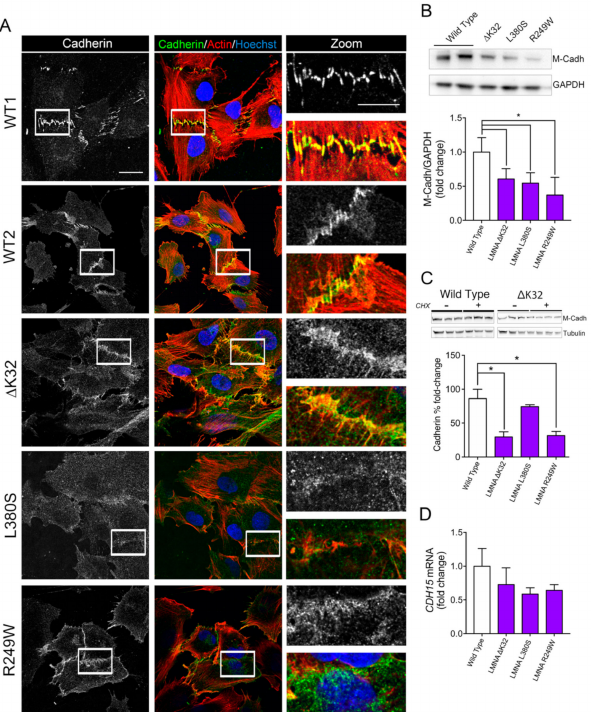
Figure 2. Cadherins in wild-type and mutant muscle cell precursors. ( A ). Confocal immunofluo- rescence images of F-actin (phalloidin, red) and cadherin (white or green) in WT (WT1 and WT2)